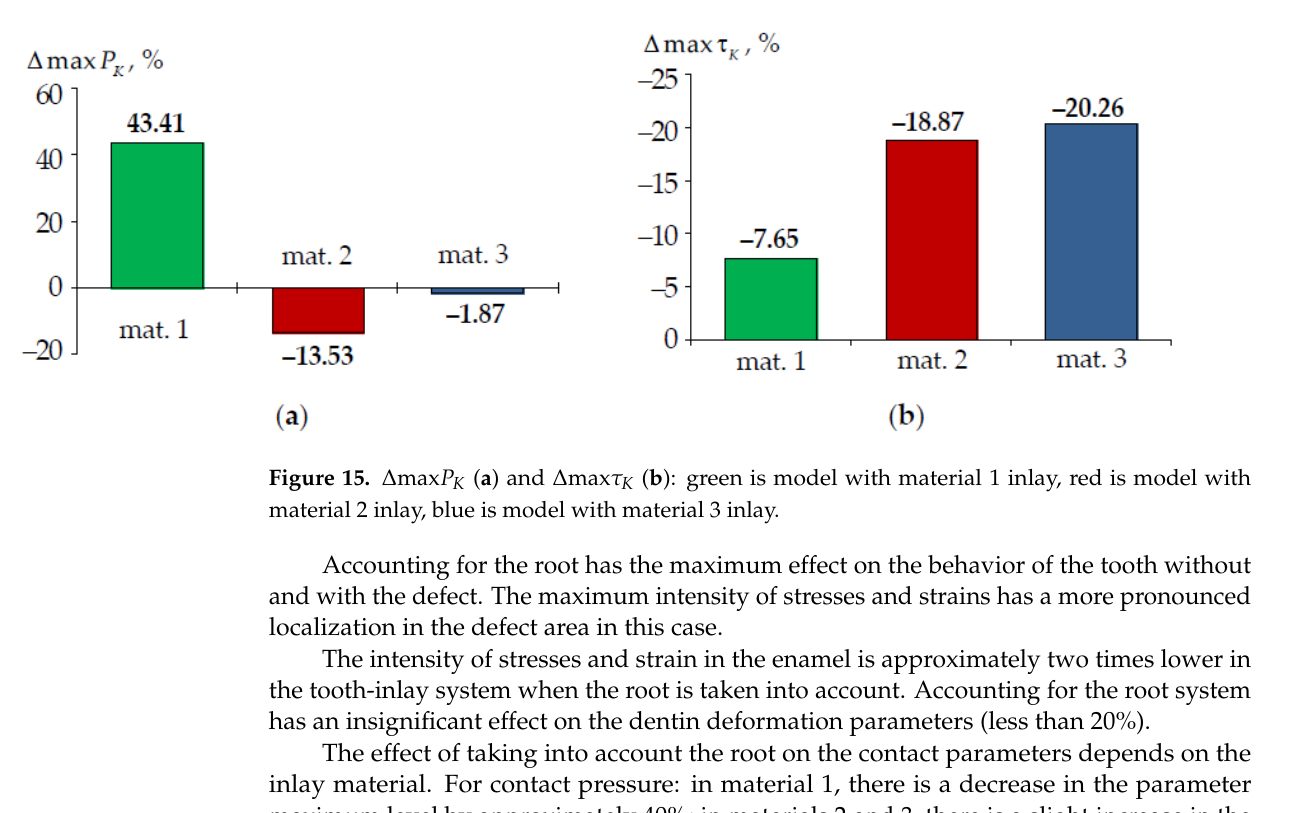
Figure 14.   max : ( a ) is enamel; ( b ) is dentine; ( c ) is inlay; dark-grey is model without defect; int light-grey is model with defect; green is model with material 1 inlay, red is model with material 2 inlay, blue is model with material 3 inlay.